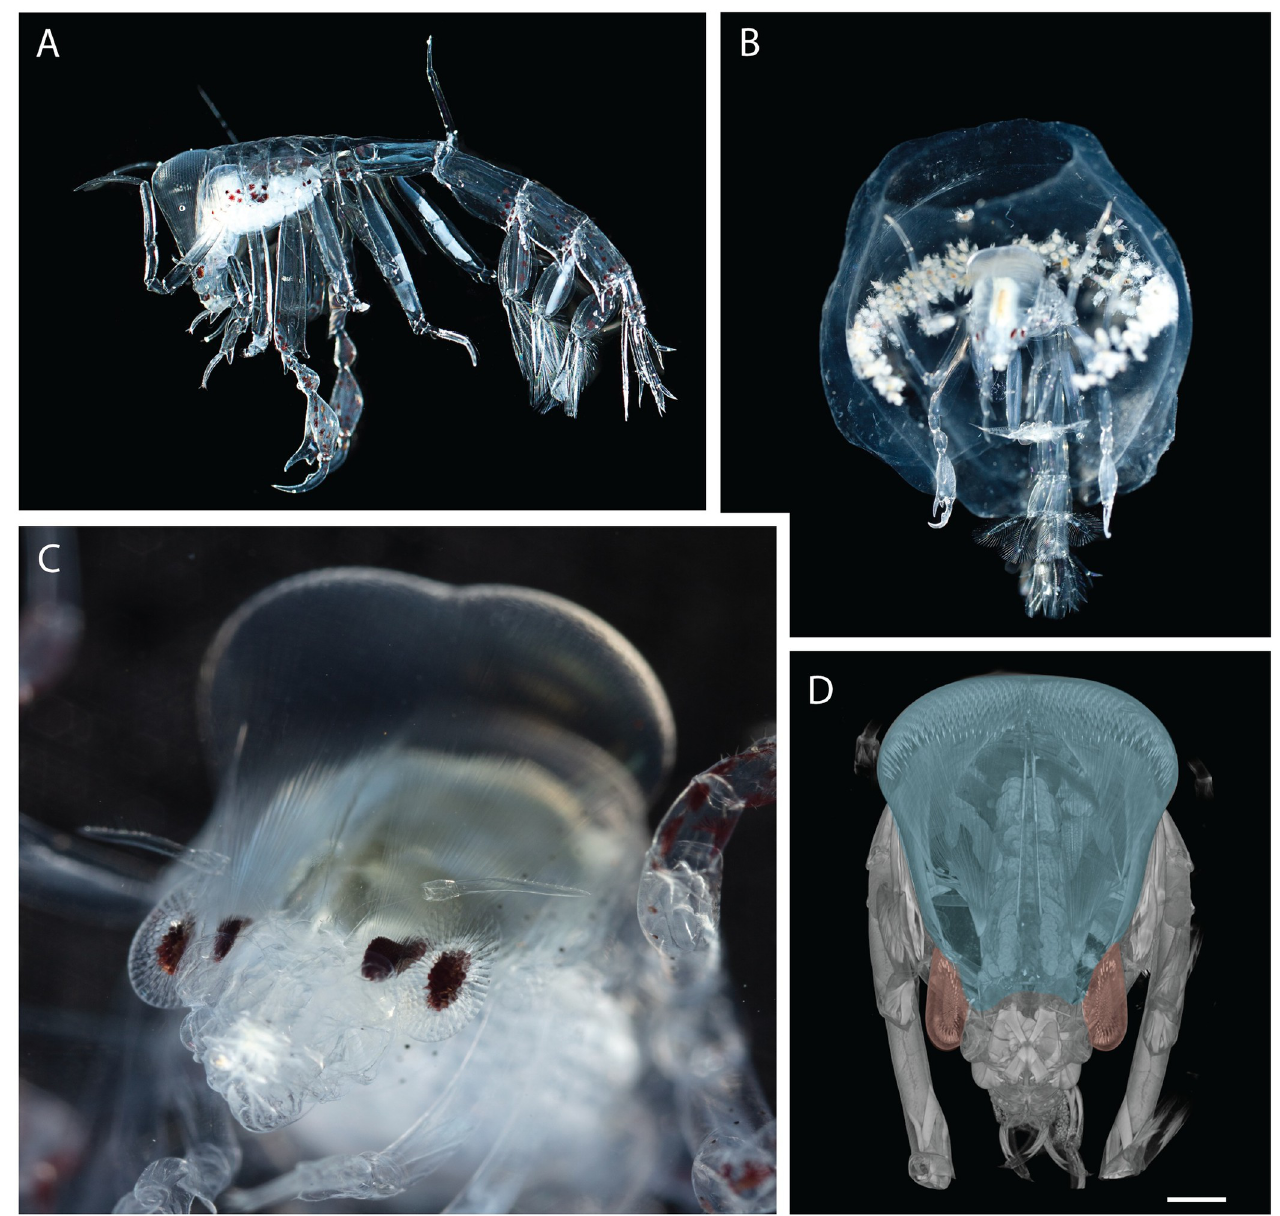
Fig 1. Phronima exemplars. (A) Lateral view of Phronima ’s body with head at left. (B) Female Phronima in barrel with brood. (C) Close-up of Phronima ’s eyes with their medial eye retinas visible at the base of their long light guides and the lateral eye retinas visible just lateral to them, closely surrounded by the distinguishable corneal lenses of the ommatidia. The lenses of the medial eyes cover the dorsal surface of the head seen as two bulges at the top of the photo. (D) Three-dimensional reconstructions of the medial and lateral eyes based on micro-computed tomography (micro-CT) image data of Specimen 2. Blue and red shading identify the medial and lateral eyes, respectively. The reconstruction was made using Dragonfly (Object Research Systems, Inc.). Scale bar 1 mm.